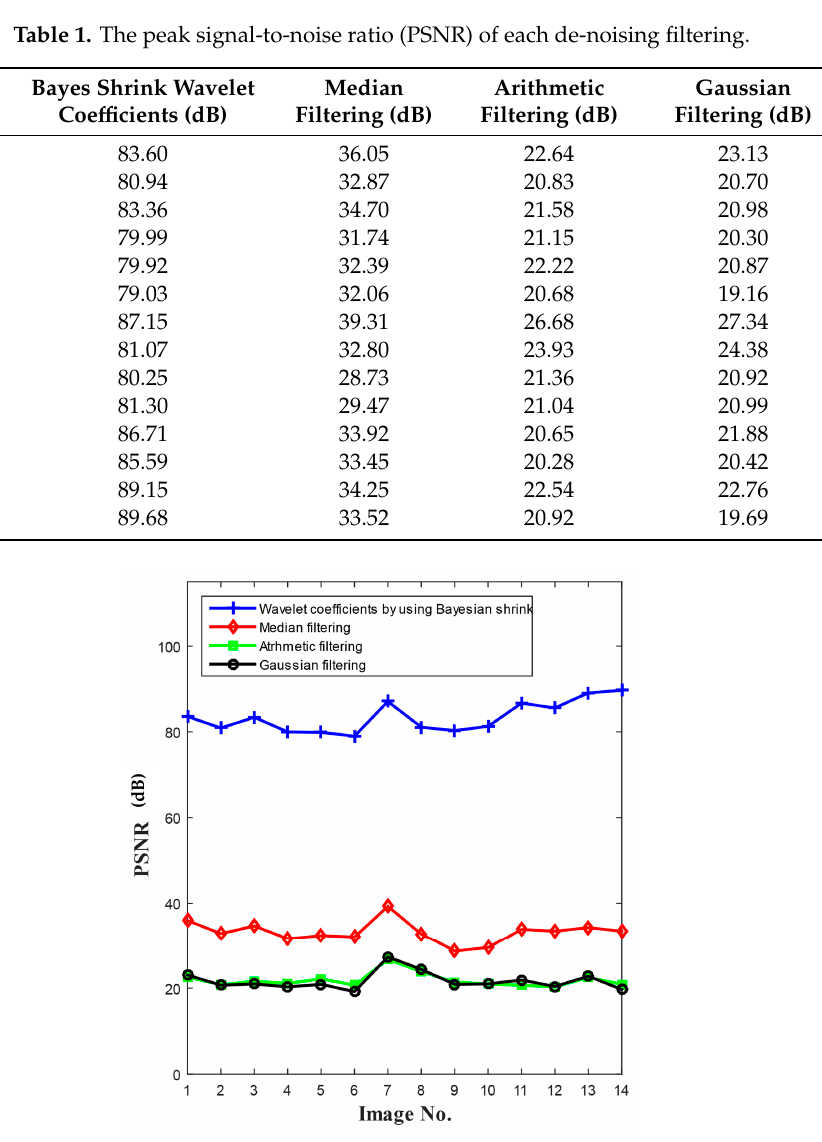
Figure 7. The chart of PSNR for each method with different 14 CCTV images. High PSNR indicates that the reconstructed image after de-noising retains the similar information of the original image, while most of the noise has been removed. Bayes shrink has the best de-noising performance since its PSNR average over 85 dB, which implies most image details can be preserved while the noise is accurately eliminated, as shown in Figure 6b. On the other hand, the PSNR of other methods is only around 20 dB to 40 dB, which means that most details of the original image have been deleted as noise. The de-noised image is distorted, as shown in Figure